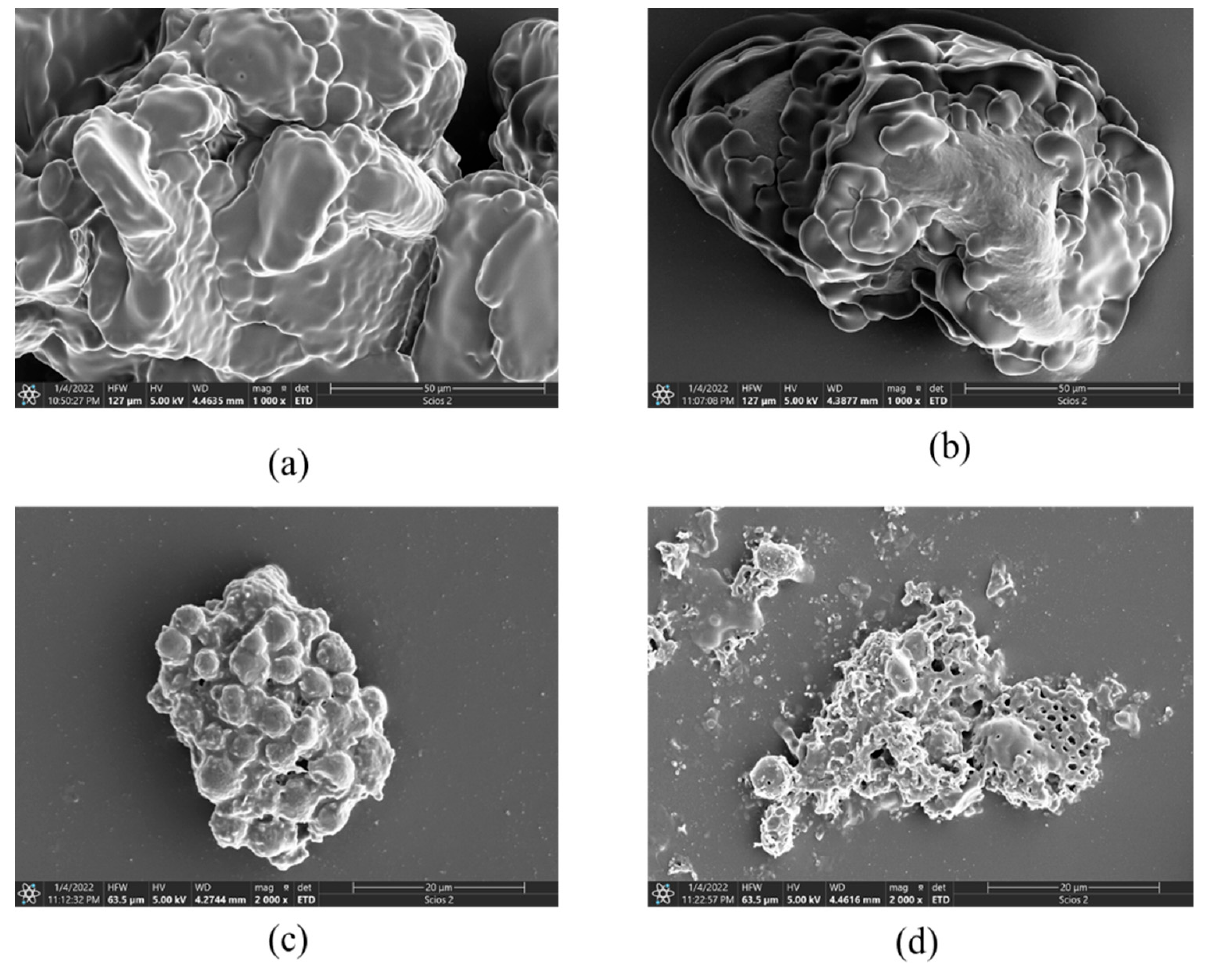
Figure 2. SEM images of freeze-dried pumpkin seed milk prepared with different pumpkin seeds. ( a ) RAW: raw pumpkin seeds, ( b ) PSM120: pumpkin seeds roasted at 120 °C, ( c ) PSM160: pumpkin seeds roasted at 160 °C, and ( d ) PSM200: pumpkin seeds roasted at 200 °C.